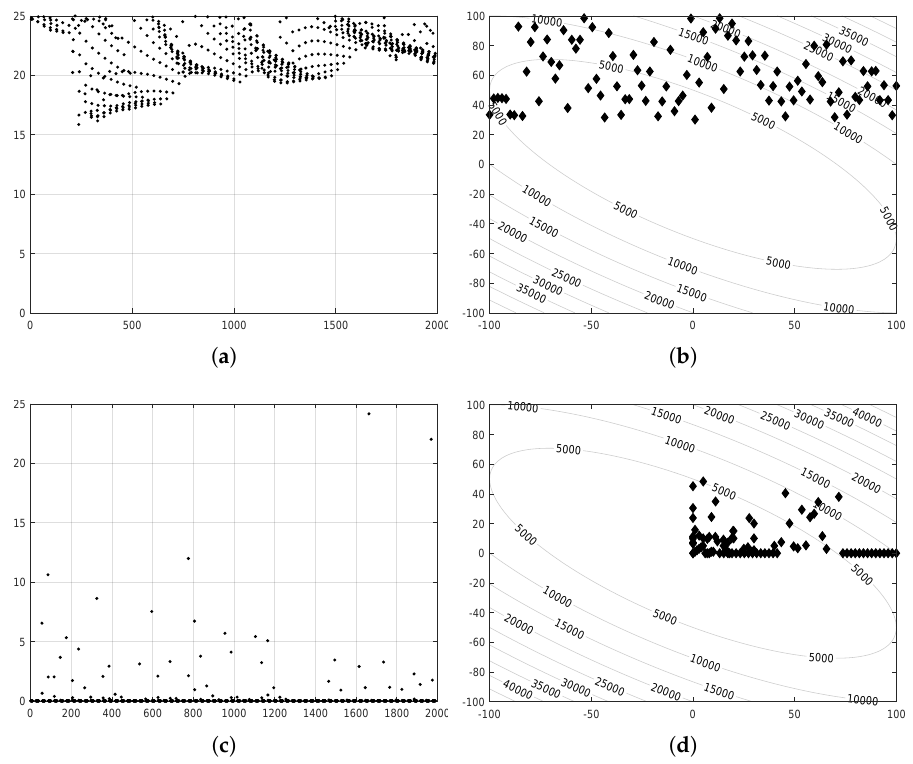
Figure 2. Average best solution (i.e., the achieved minimum, described by the y-axis) in terms of the number of objective function evaluations (x-axis) for the benchmark function f 3 using ( a ) SSA and ( c ) ISSA; corresponding convergence visualizations ( b , d ) in accordance with ( a , c ). ( b , d ) are the contour plots of the function f 3 , the x and y-axis represent the dimensions of the function, and the markers represent the evaluated points by running the optimization